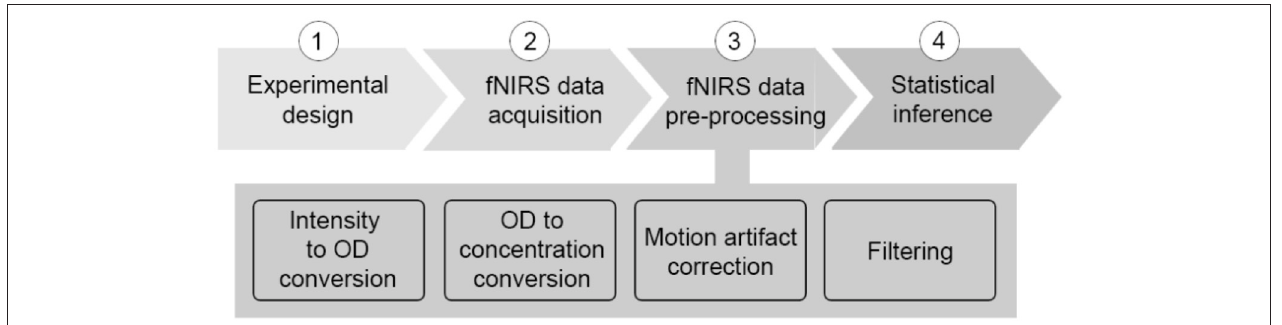
FIGURE 1 | Typical neuroscience experiment pipeline with